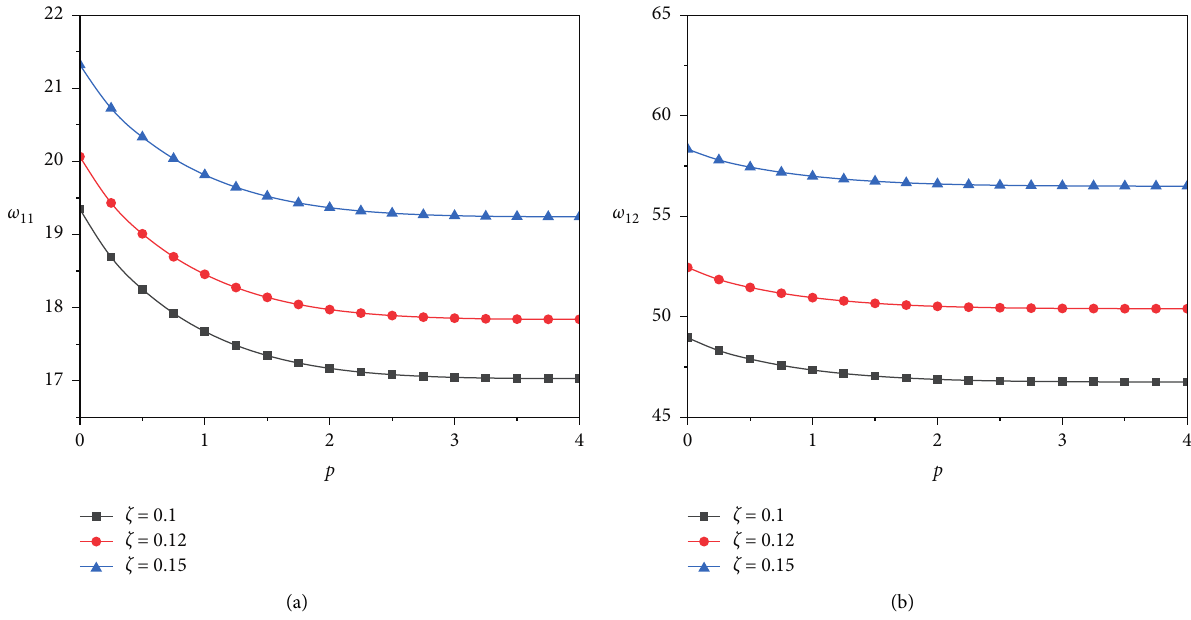
Figure 7: Variation of the vibration frequency with respect to the gradient index under different material characteristic scale parameters. (a) The first-order vibration frequency. (b) The second-order vibration